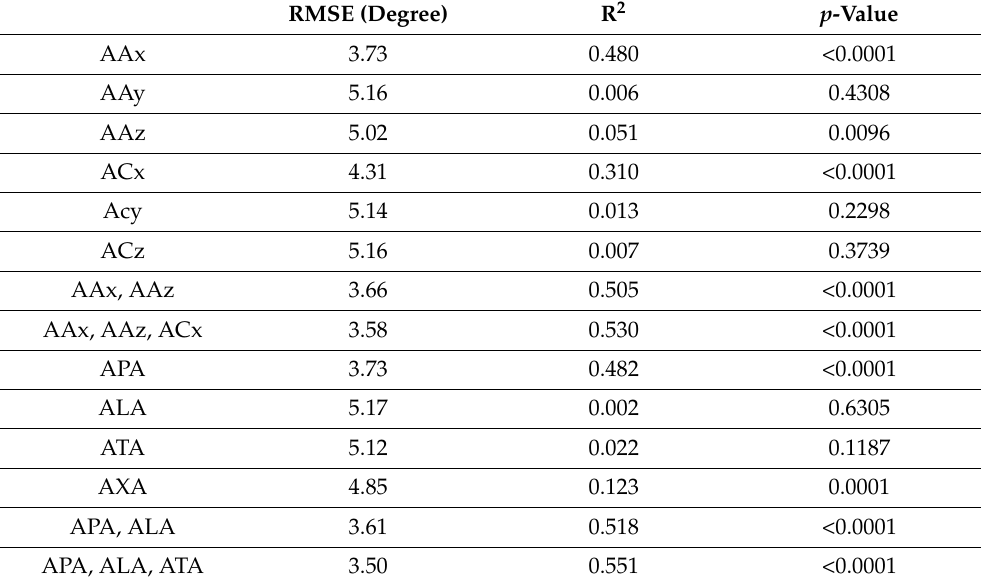
Table 1. Root mean square errors (RMSE), coefficients of determination (R 2 ), and p -values of simple and stepwise multiple linear regressions between several acromion landmark coordinates and angles and the glenoid retroversion angle (GRA), for normal